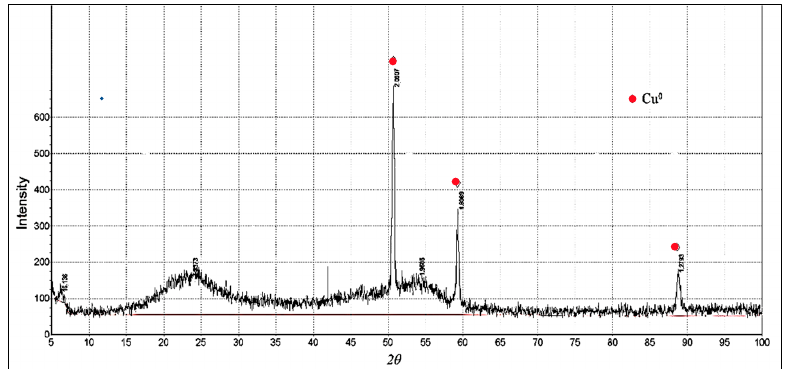
Figure 5. XRD pattern of the precipitation formed during phosphine oxidation by aqueous copper– ammonia complexes; labelled peaks at 2.09, 1.81, and 1.28 attributed to Cu 0 (ASTM 4-0836).